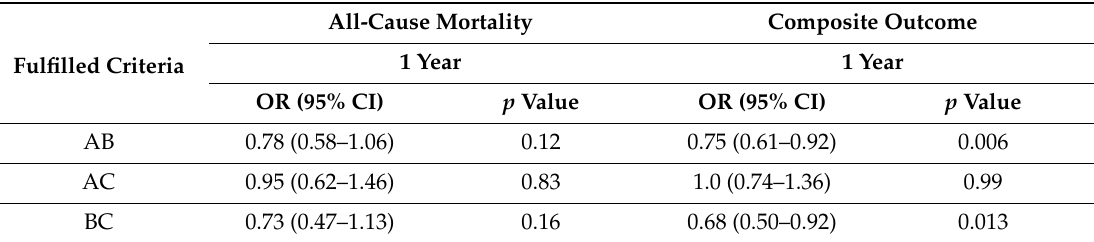
Table 4. Relationship between ABC pathway components criteria and clinical